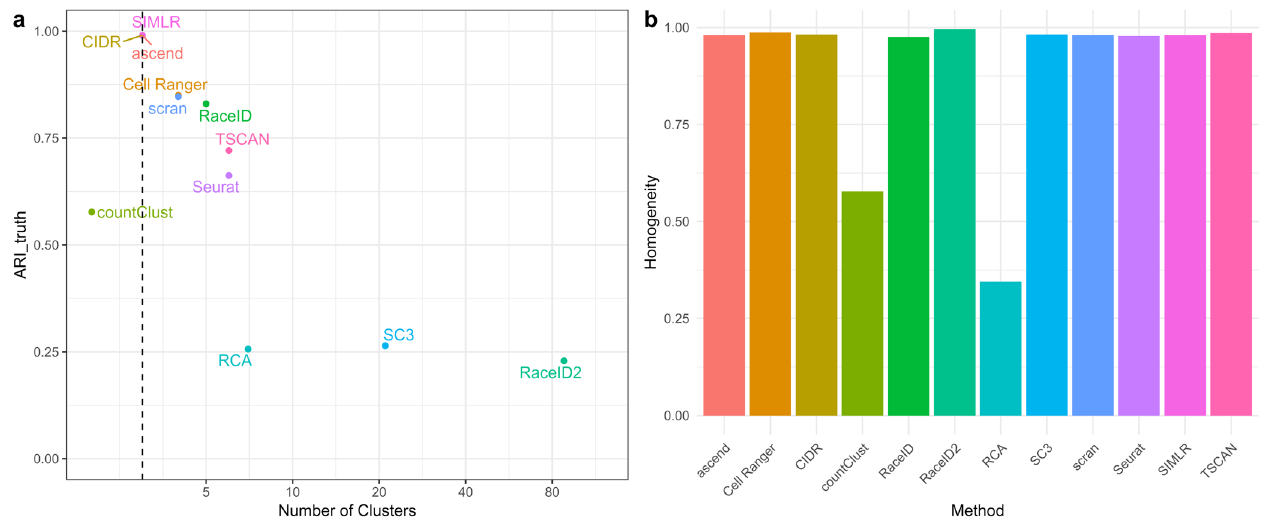
Figure 1. Performance on the gold standard dataset. ( a ) ARI_truth of each method with regards to the truth versus the number of clusters. The dashed line indicates the true number of clusters. ( b ) Homogeneity of clusters of each method, given the